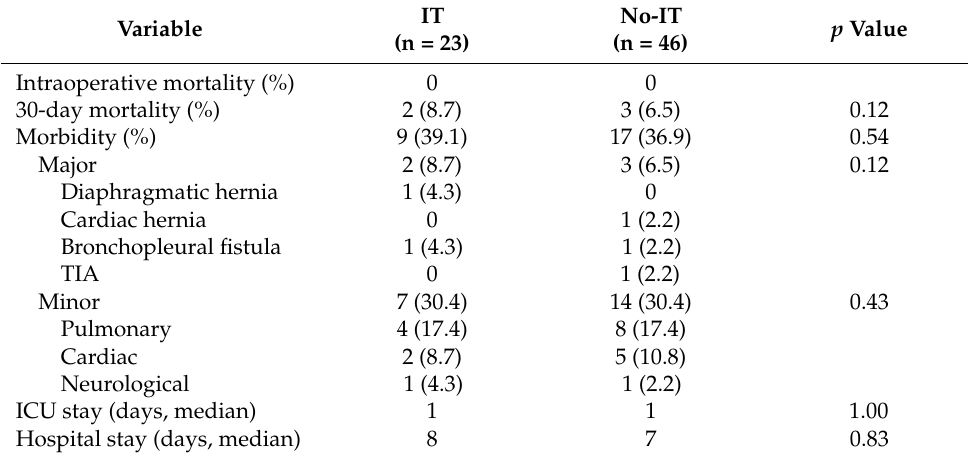
Table 2. Postoperative